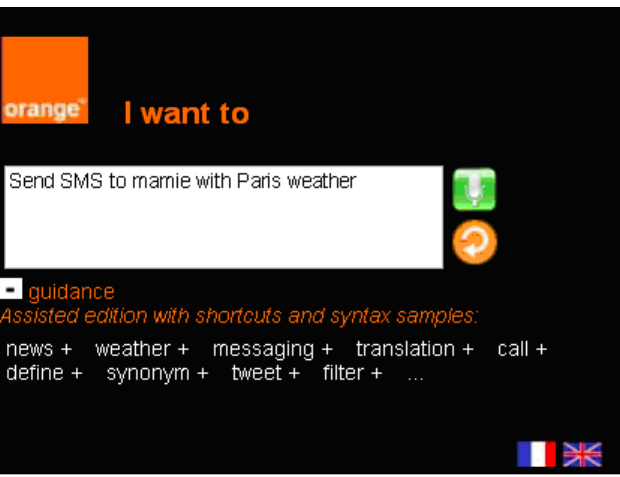
Figure 12. Interface of the natural language composer.